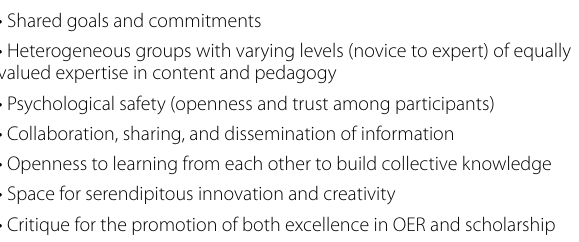
Table 1 CoP guiding principles that promote